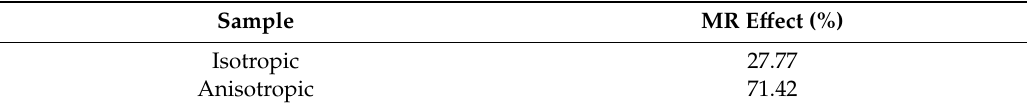
Table 5. The MR e ff ect on the storage modulus of the MRE.